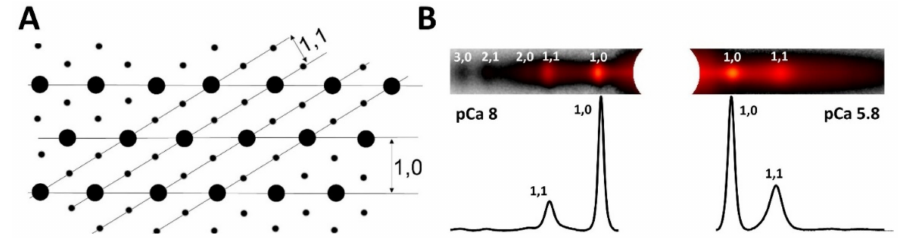
Figure 2. Equatorial reflections from muscle X-ray diffraction patterns ( A ) Cross-sectional view of sarcomere A band. The thick filaments (thick dots) form a 2D hexagonal lattice and the thin filaments (thin dots) interdigitate into the trigonal points between the thick filaments. ( B ) Equatorial reflections (up panel) and their one-dimensional intensity profiles (bottom panel) from permeabilized murine myocardium under resting (pCa 8) and sub-maximally activated state (pCa5.8) (based on reference